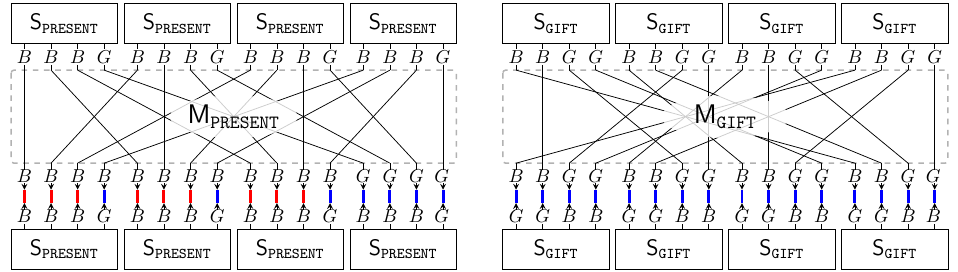
Figure 4: Consecutive single active bit propagations of PRESENT and